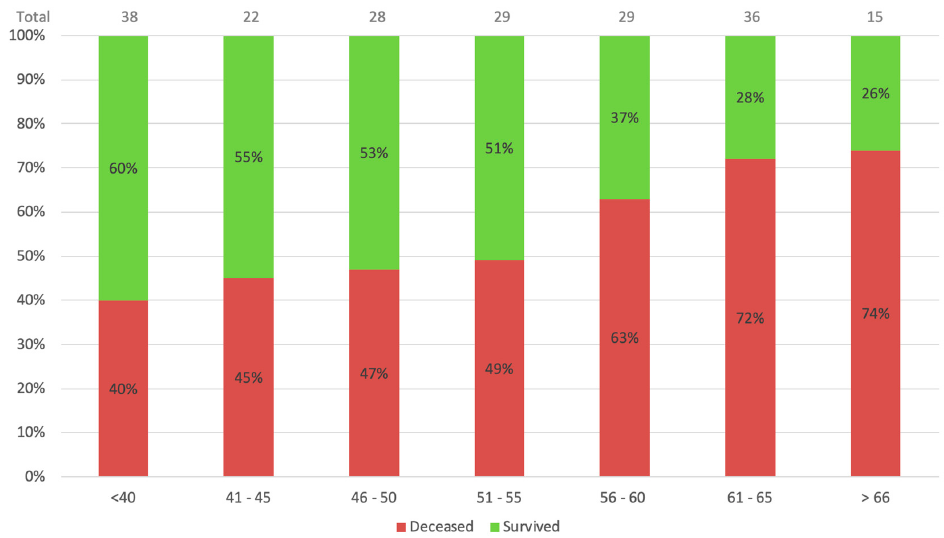
Figure 1. Age-related mortality. Figure 1 demonstrates the mortality and survival rates according to Figure 1. Age- related mortality . Figure 1 demonstrates the mortality and survival rates according different age groups. to different age groups.